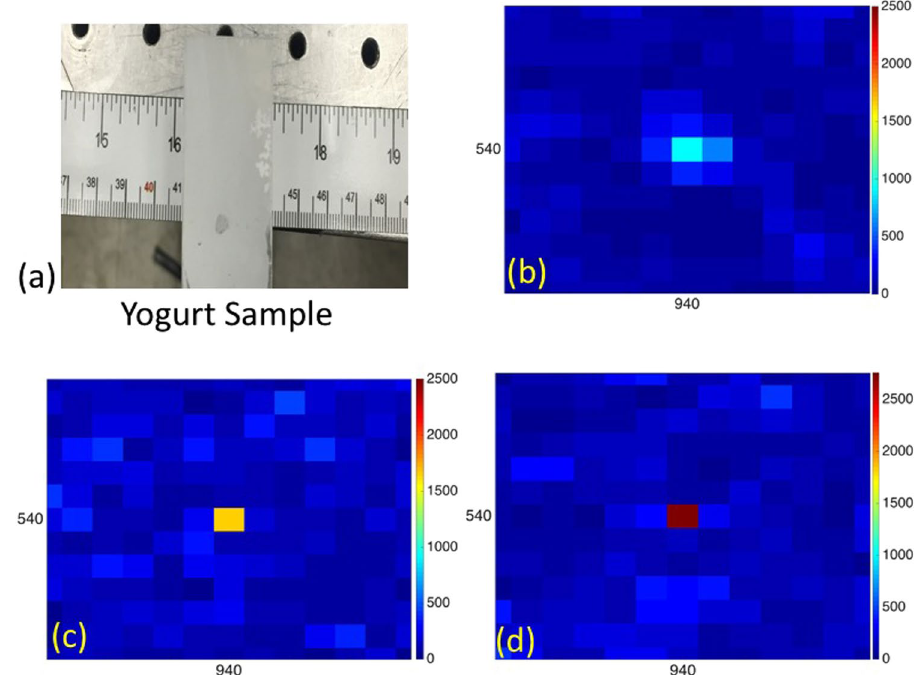
Figure 5. The intensity at pixels surrounding (940, 540) after a focus is generated at (940, 540) using the SDP algorithm when ( a ) M = 36, ( b ) M = 64 and ( c ) M = 100, respectively.